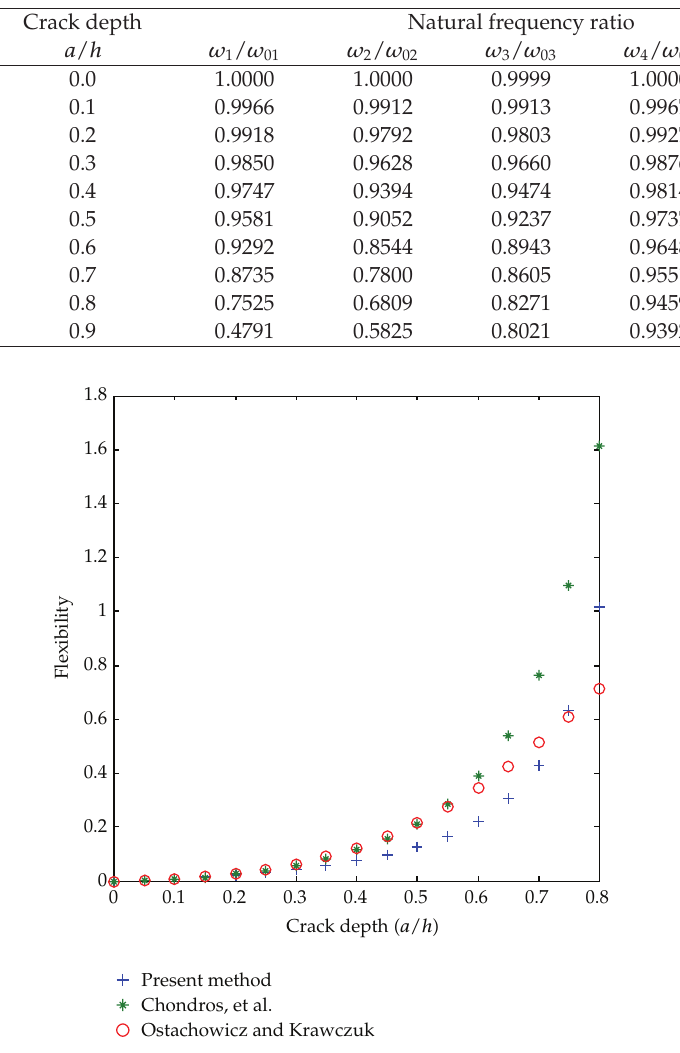
Figure 5: Nondimensional cracked section flexibility